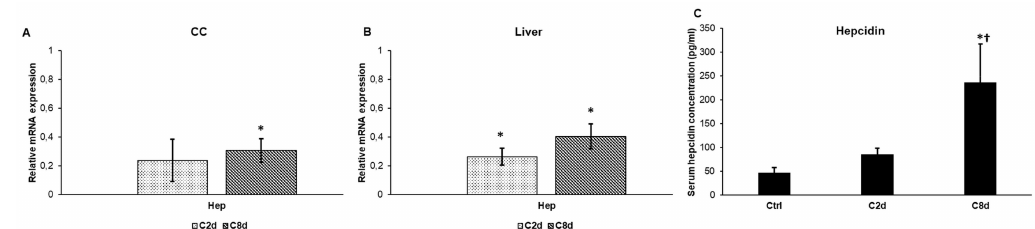
Figure 2. Relative hepcidin mRNA expression and serum hepcidin concentrations in non-treated and CZ-treated groups. Real Time PCR was performed with SYBR green protocol using gene specific primers. Relative expression of the control was regarded as 1. Hepcidin measurements were determined using mouse hepcidin-25 ELISA kit according to the manufacturer’s protocol. ( A ) Hepcidin mRNA expressions in corpus callosum (CC). ( B ) Hepcidin mRNA expressions in the liver. ( C ) Serum hepcidin concentrations. The bars represent mean values and error bars represent standard errors of the mean (SEM) for three independent determinations. For statistical analyses, Student’s t -test and two-sample t -tests were used. The asterisk shows p < 0.05 compared to the controls, the cross indicates the di ff erence p < 0.05 between the treated groups, n = 6 in each